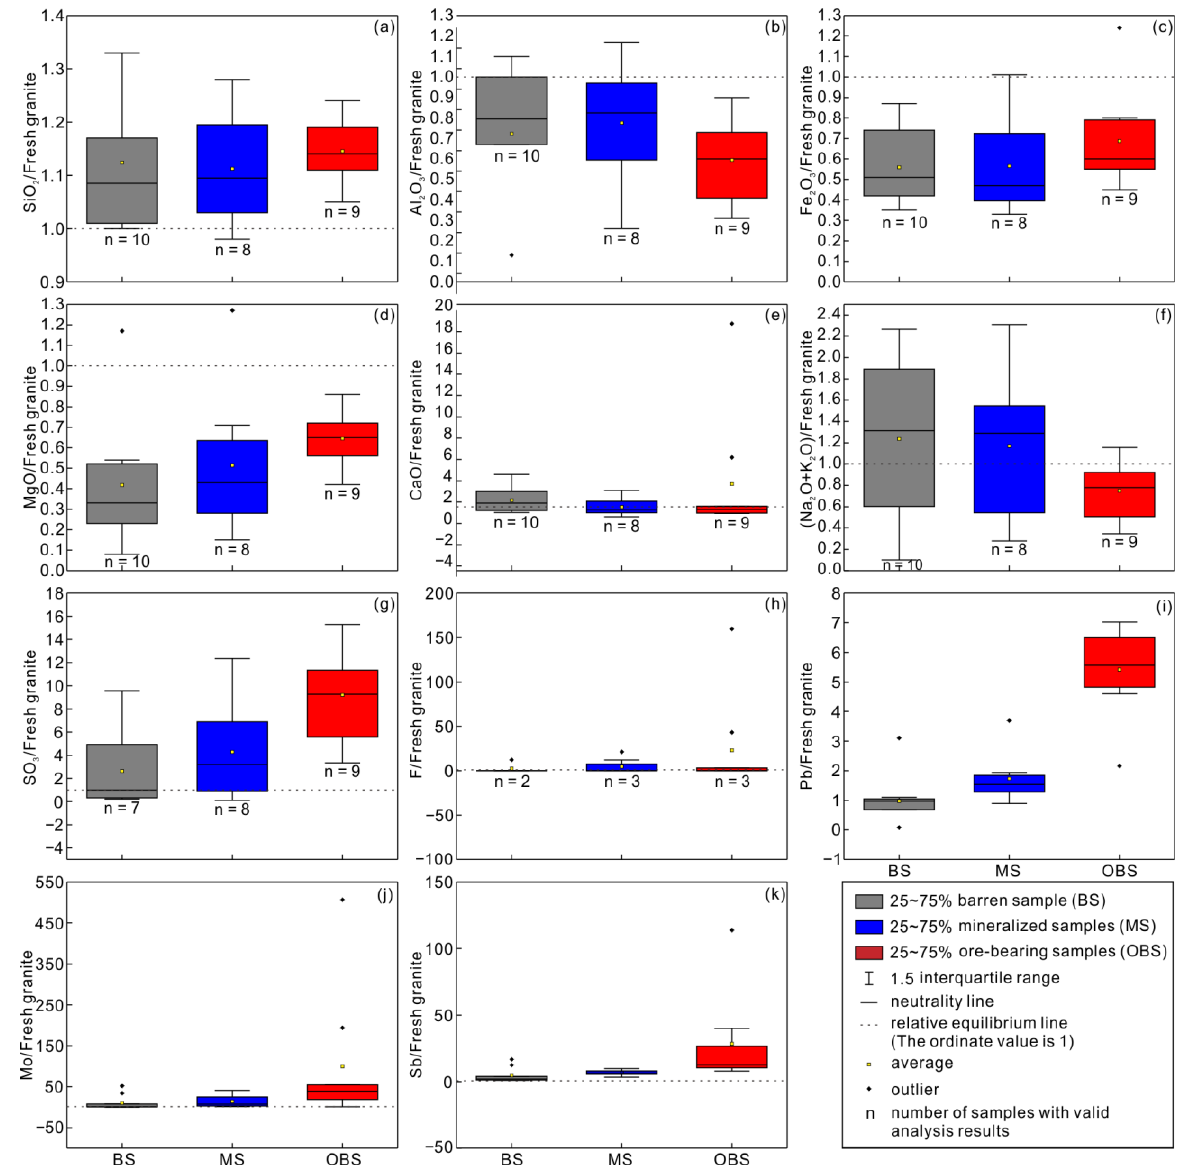
Figure 3. Box-whisker diagrams showing relative contents of important elements, namely Pb, Mo, and Sb, in altered SJOF granites. ( a ) SiO 2 , ( b ) Al 2 O 3 , ( c ) Fe 2 O 3 , ( d ) MgO, ( e ) CaO, ( f ) Na 2 O + K 2 O, ( g ) SO 3 , ( h ) F, ( i ) Pb, ( j ) Mo, ( k ) Sb.